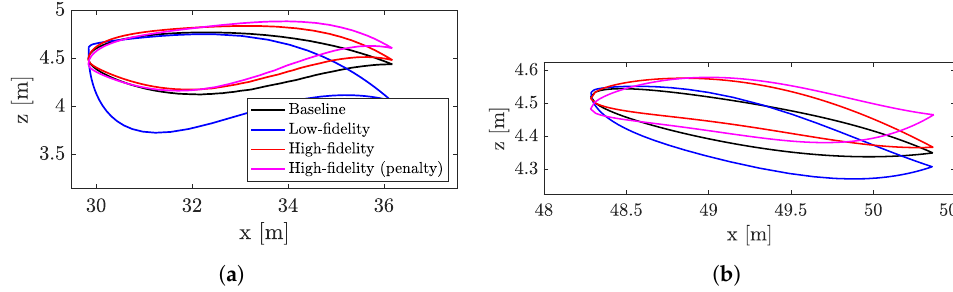
Figure 10. Baseline and optimized geometries. For reference, the low- and high-fidelity angles of attack are 1.339148 and 0.8001988 degrees, respectively. ( a ) Yehudi; ( b )